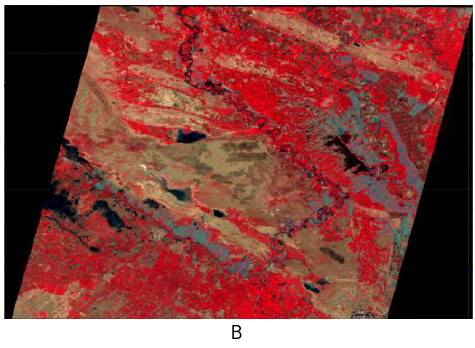
Figure 8. flood-affected agricultural